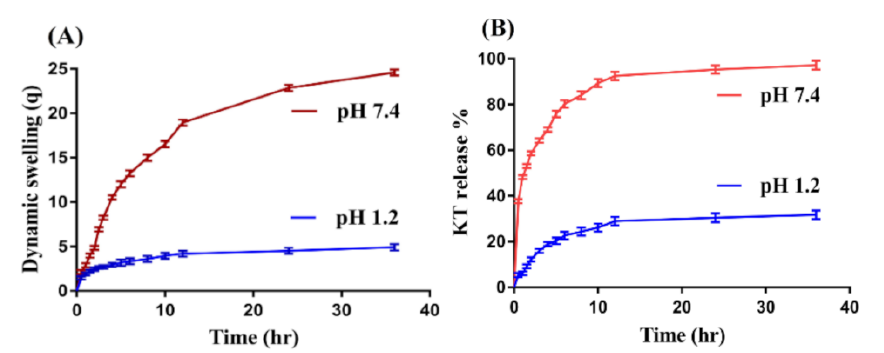
Figure 4. Effect of pH on ( A ) dynamic swelling, and ( B ) KT percent release from CP/SpScPAA hydrogels. Table 2. Dynamic swelling and percent drug release of CP/SpScPAA hydrogels. F.